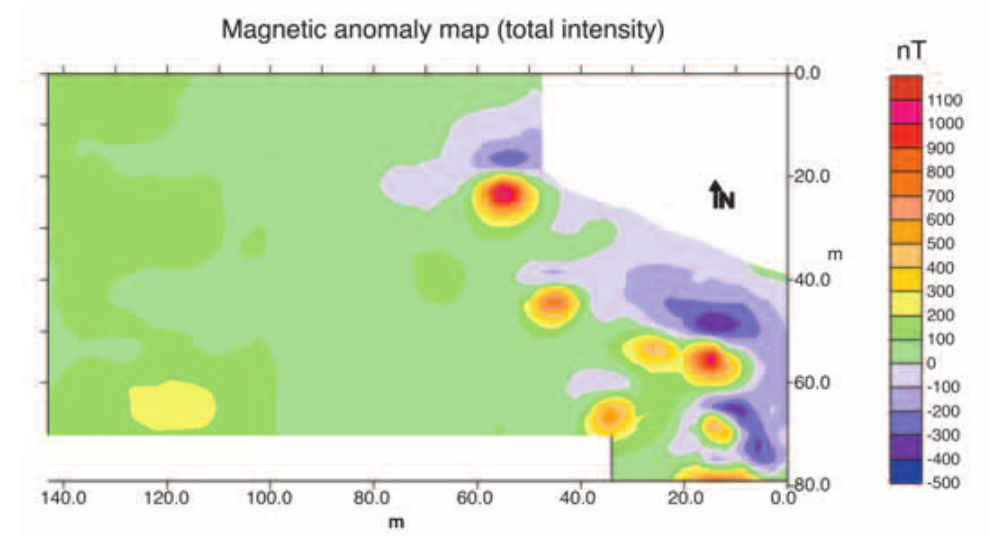
Fig. 3. First map of the magnetic anomalies of the total intensity field on the whole